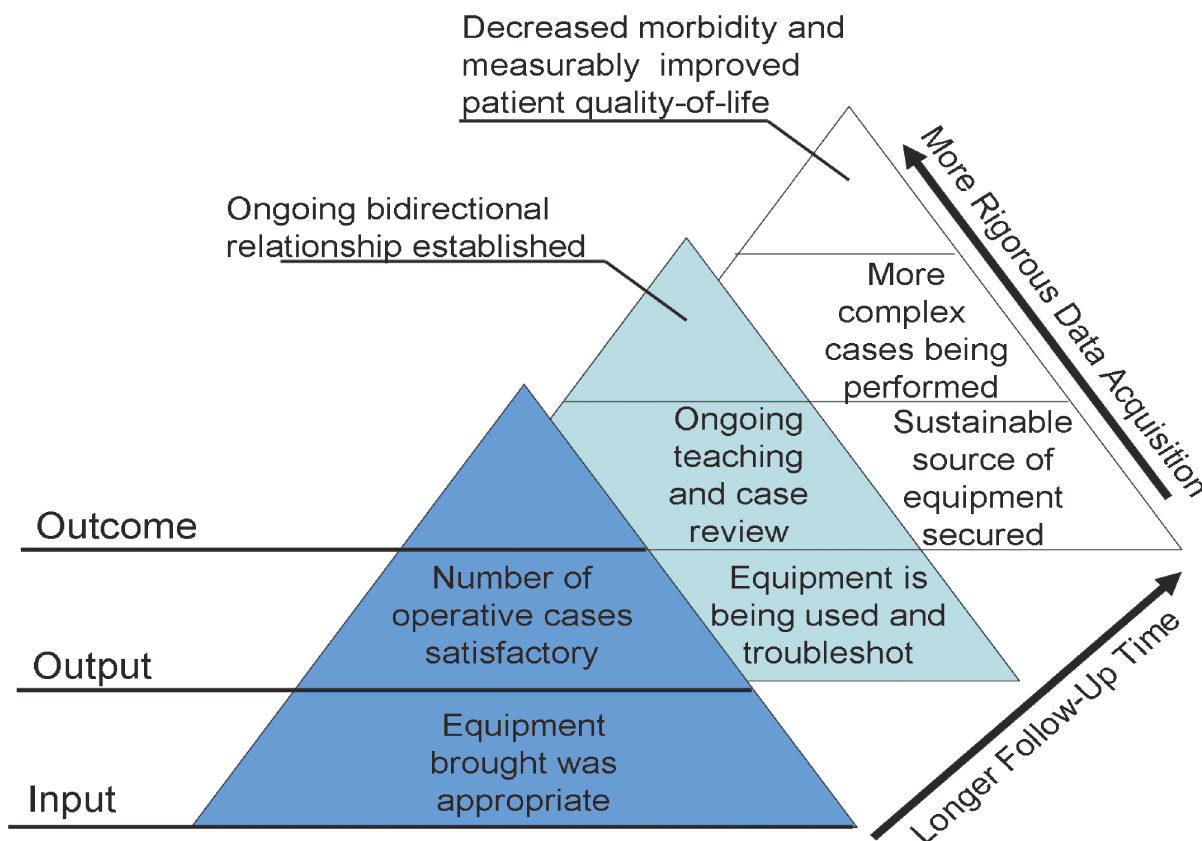
Fig 2. Longitudinal and hierarchical organization of the FAIRNESS framework. The FAIRNESS framework encompasses indicators that are increasingly acquired through rigorous data collection as well as with longer follow-up